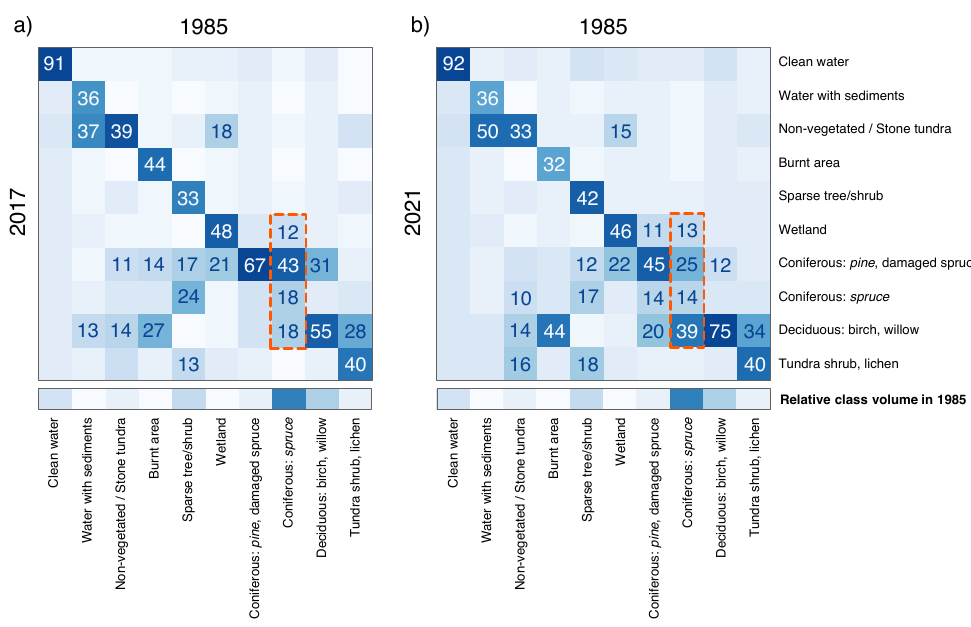
Figure 9. Land cover change detection between 1985 and years ( a ) 2017 and ( b ) 2021. Any change in the land cover in the target year compared to 1985 is marked in pink. The original land cover colour legend is used for classes that remained unchanged.